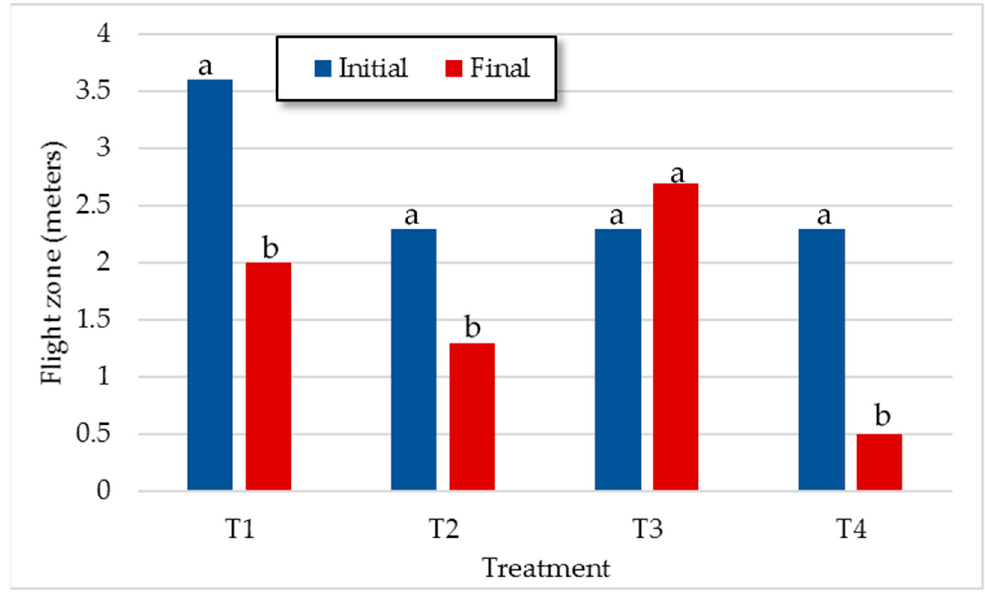
Figure 3. Mean values of initial and final flight zone for each treatment. a, b Means within the same treatment with different letters differ with p < 0.05.